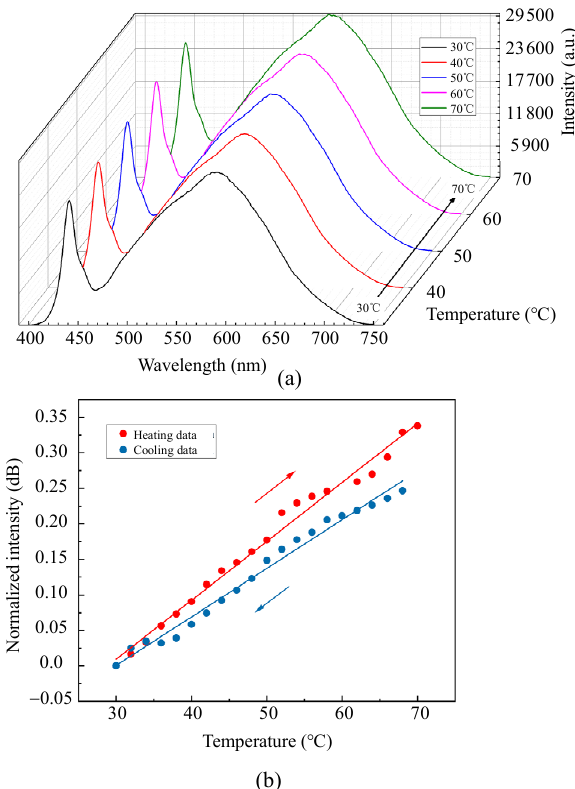
Fig. 4 Temperature-dependent intensity change of the HMF sensor in pure water ( d =16.8  m, S =6.48 mm,  =5.53°, and N =2): (a) variation of typical spectra and (b) normalized intensity as a function of the temperature change. (The red and blue dots represent the increasing and decreasing processes, respectively. The numerical fitting of the process is carried out by the partial least squares